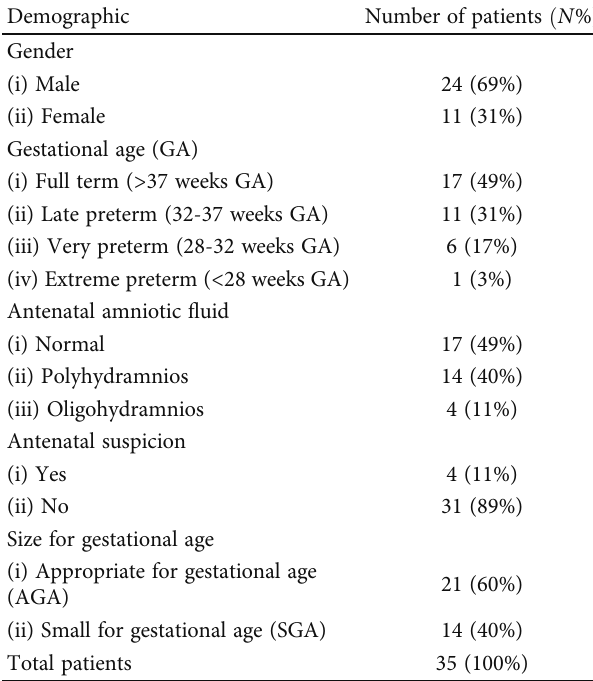
Table 1: Demographic data.